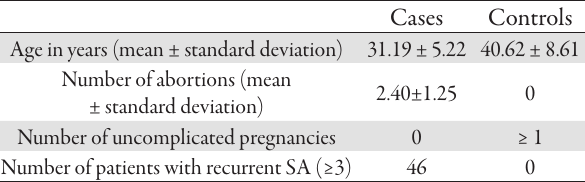
Tab. 1. Main parameters of spontaneous abortion (SA) cases and control